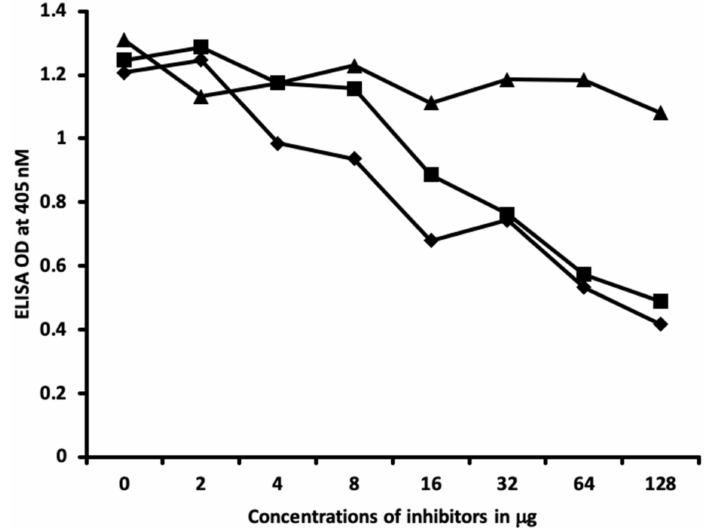
Figure 8. Binding of thyroxine deiodinase antibody to aflatoxin-HSA in the absence or presence of aflatoxin-HSA, formaldehyde-HSA, and parabens-HSA in concentrations of 0, 2, 4, 8, 16, 32, 64, and 128 µ g / mL. (cid:7) = Aflatoxin-HSA; (cid:4) = formaldehyde-HSA; (cid:78) =